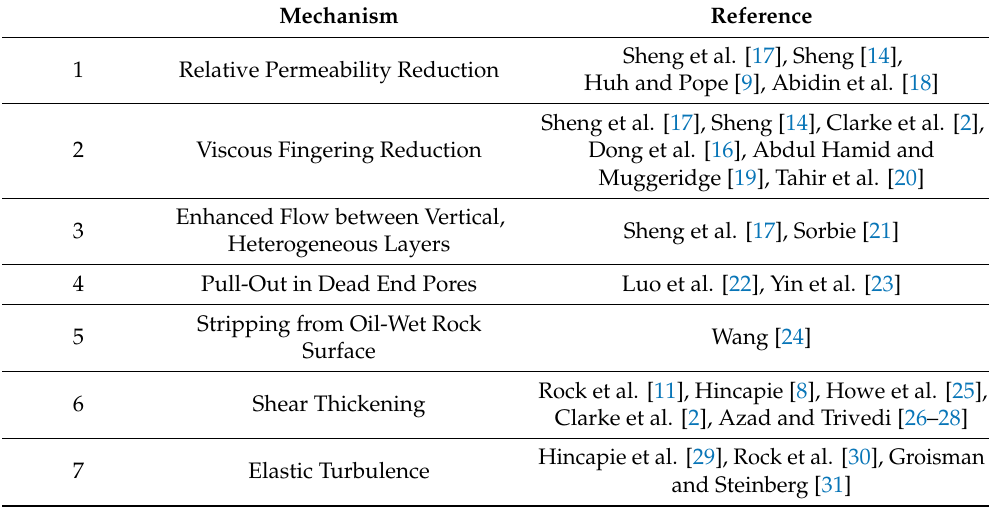
Table 1. Overview of the mechanism reported that could explain polymer enhanced oil recovery (EOR)